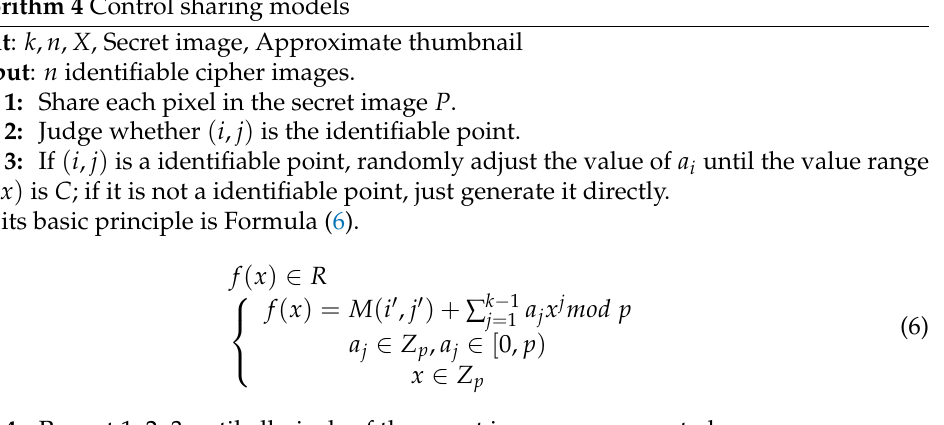
Algorithm 4 Control sharing